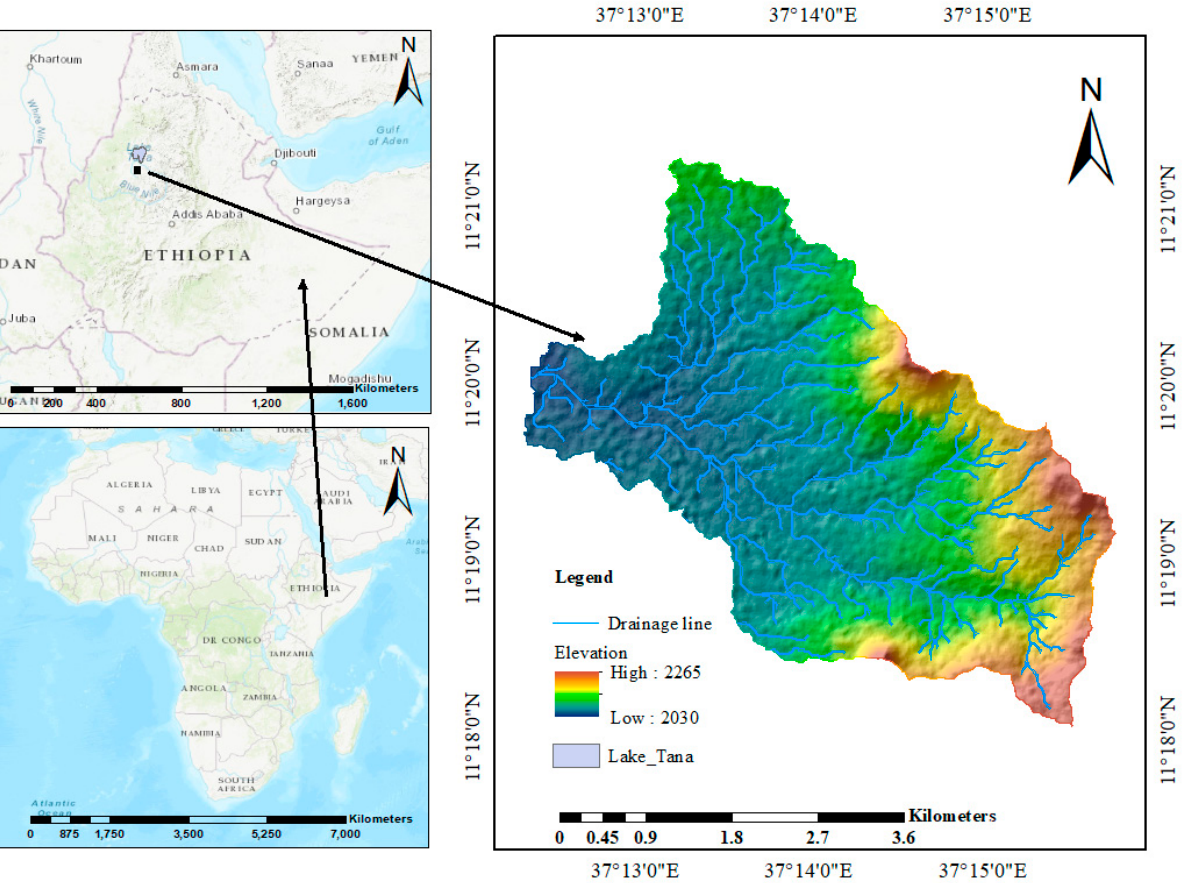
Figure 1. Study area map and elevation range of the Minzir